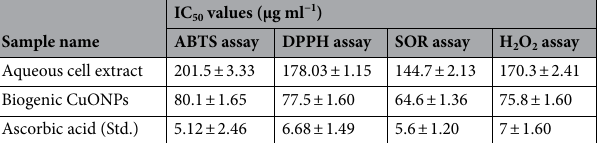
Table 1. Antioxidant activity of biosynthesized CuONPs. Average of three independent